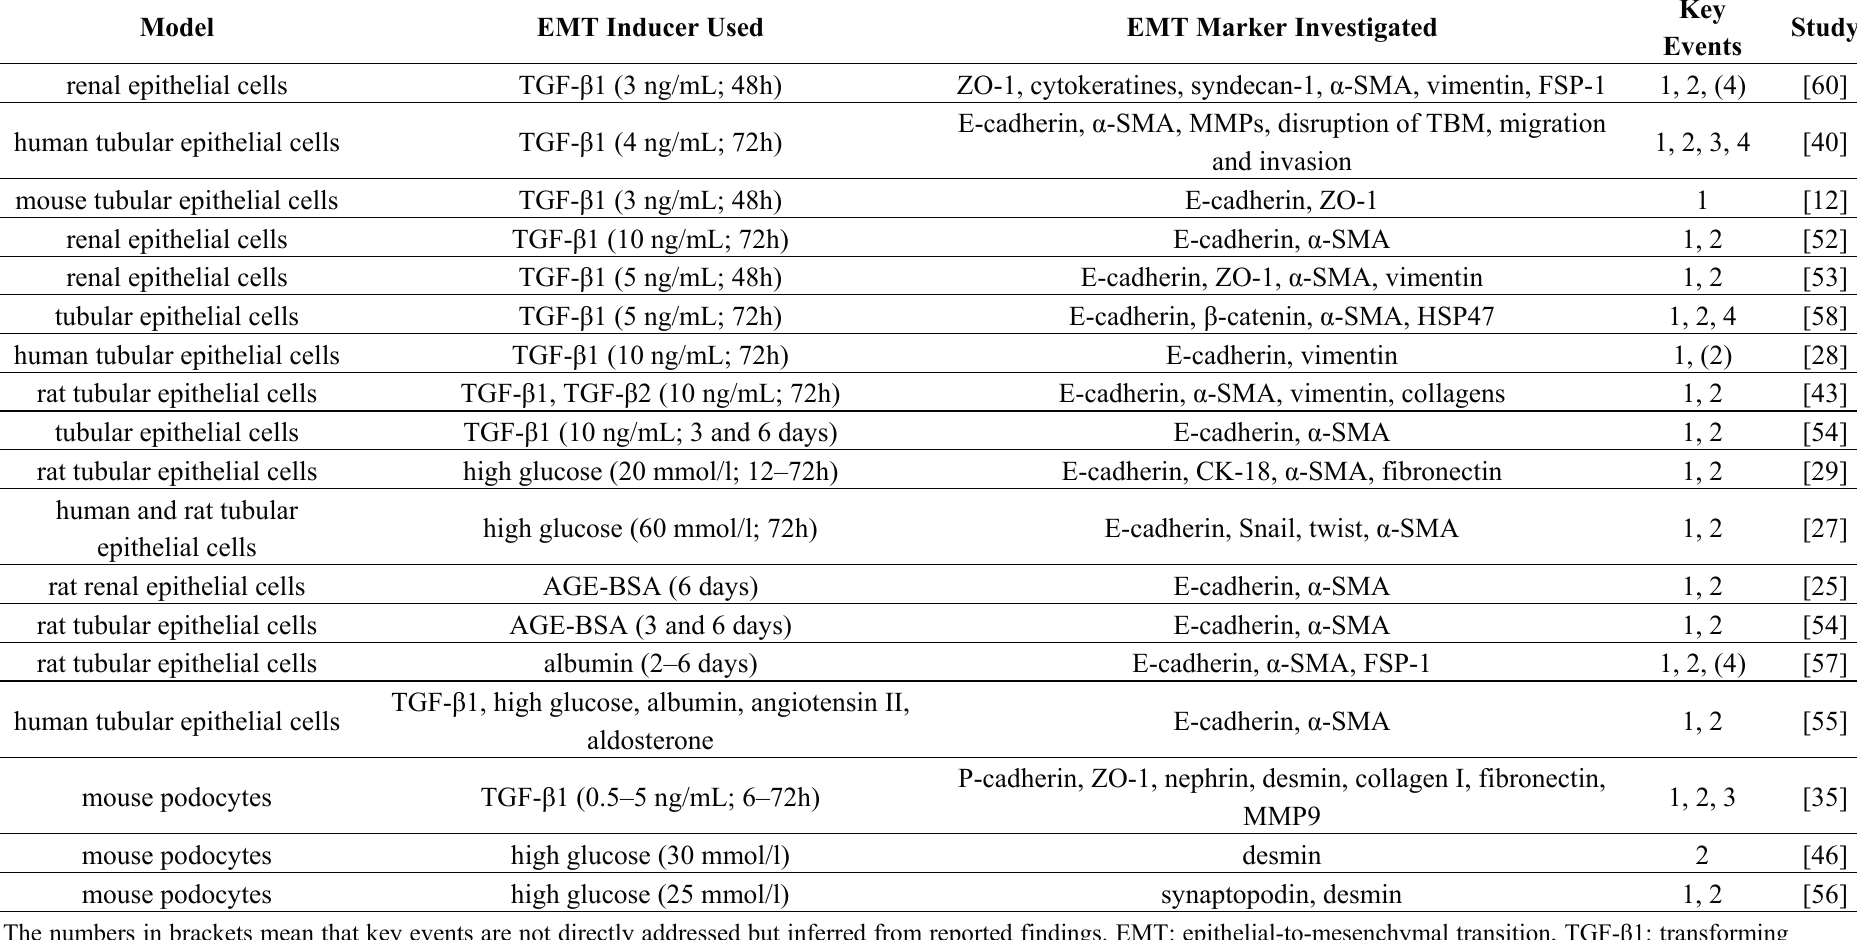
Table 1. Overview of the experimental designs of the major studies that demonstrated evidence for EMT in